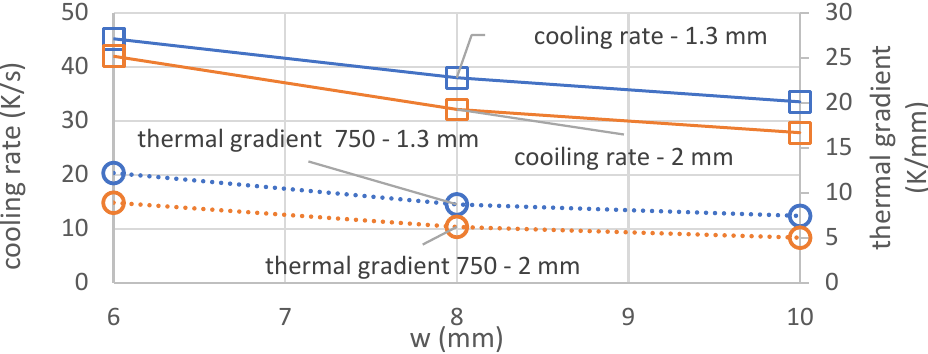
Figure 5. Cooling rate and thermal gradient experimentally measured for L = 25 mm at different values of w.